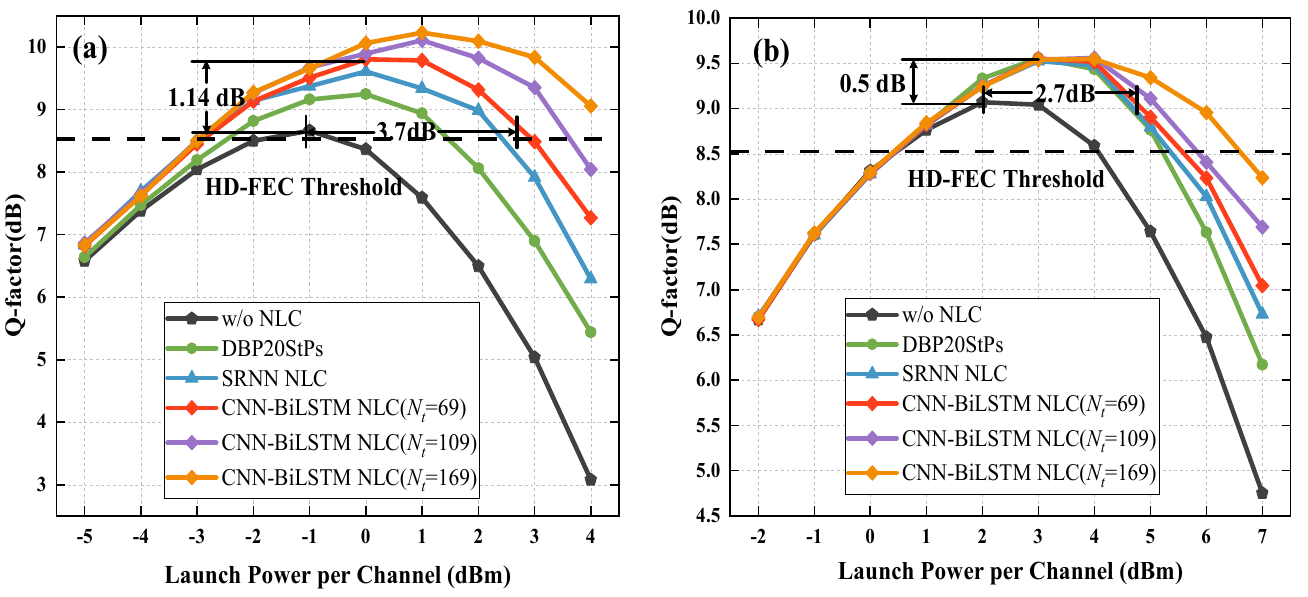
Figure 10. Q-factor of different NLC schemes versus launch power per channel for 5-channel WDM system. ( a ) 28 GBaud PDM-16QAM after 1600 km transmission; ( b ) 85 GBaud PDM-64QAM after 400 km transmission.